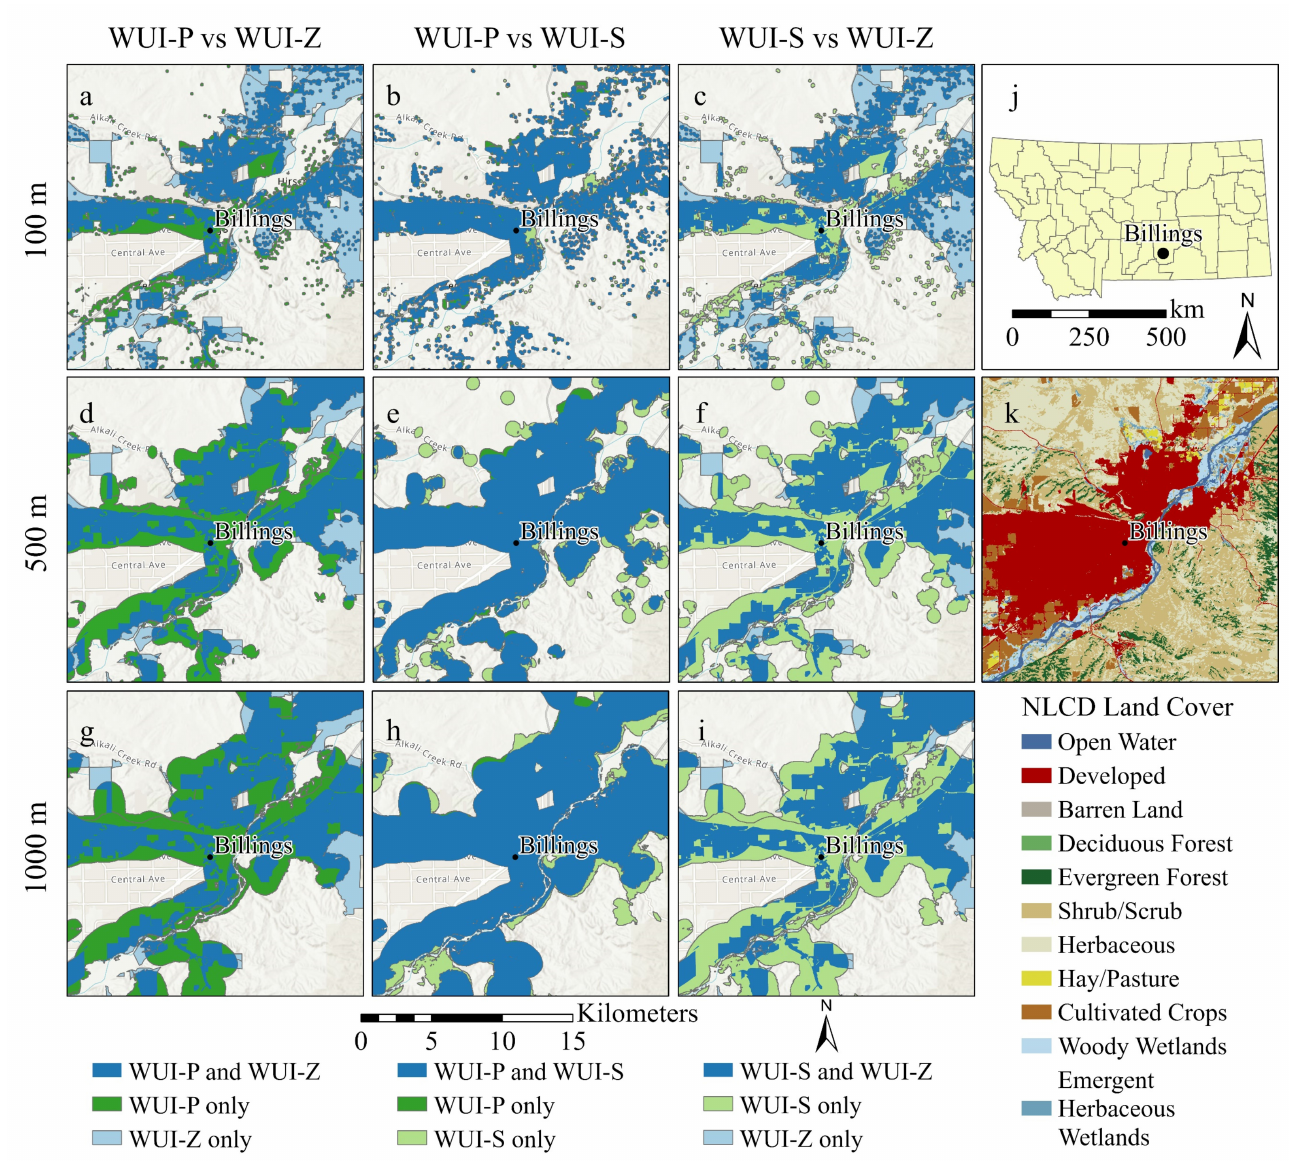
Figure 6. ( a – i ) WUI comparison results around Billings, Montana ( j ) at 100 m, 500 m, and 1000 m buffer distances and the land cover map ( k ) in